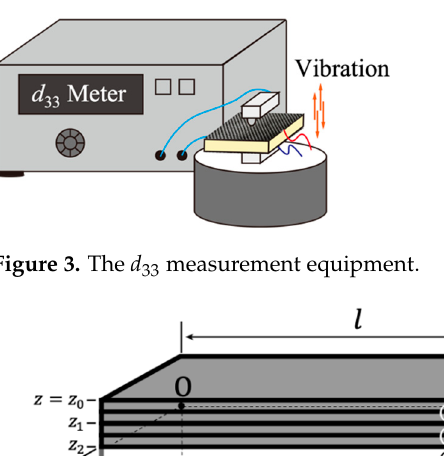
Figure 3. The d 33 measurement equipment.